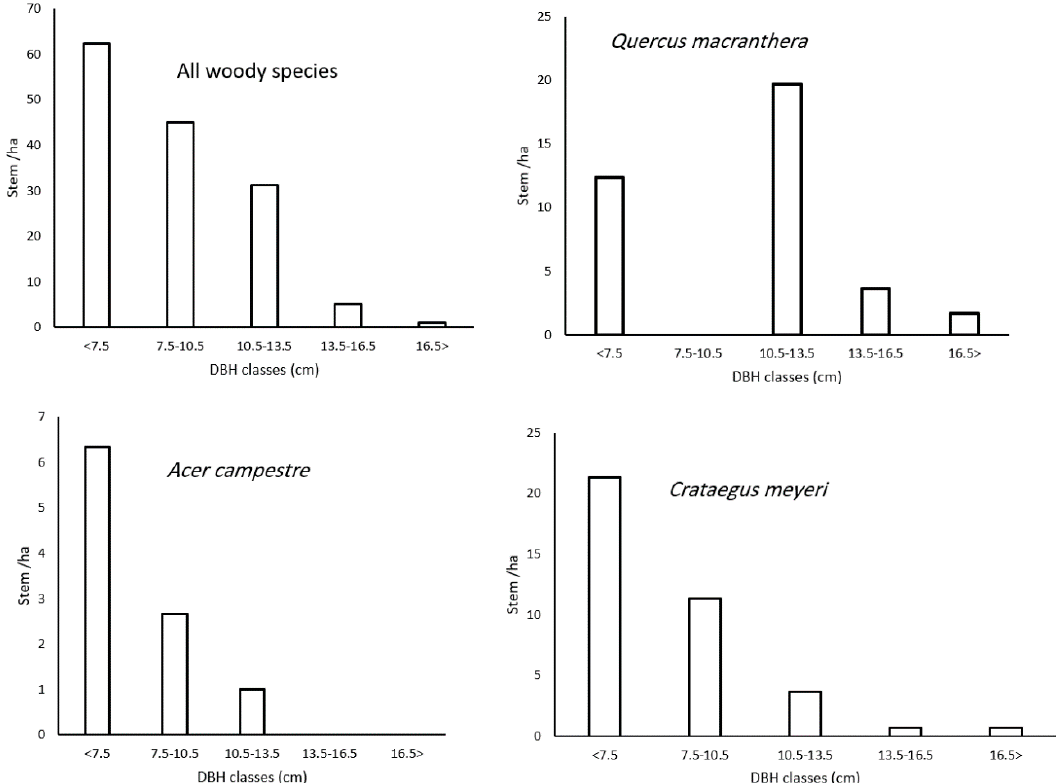
Figure 3. Tree (DBH ≥ 5 cm and height ≥ 1.5 m) density by diameter at breast height (DBH) class and species in a naturally-regenerated broadleaf forest in the Arasbaran biosphere reserve in Iran ( n = 30).